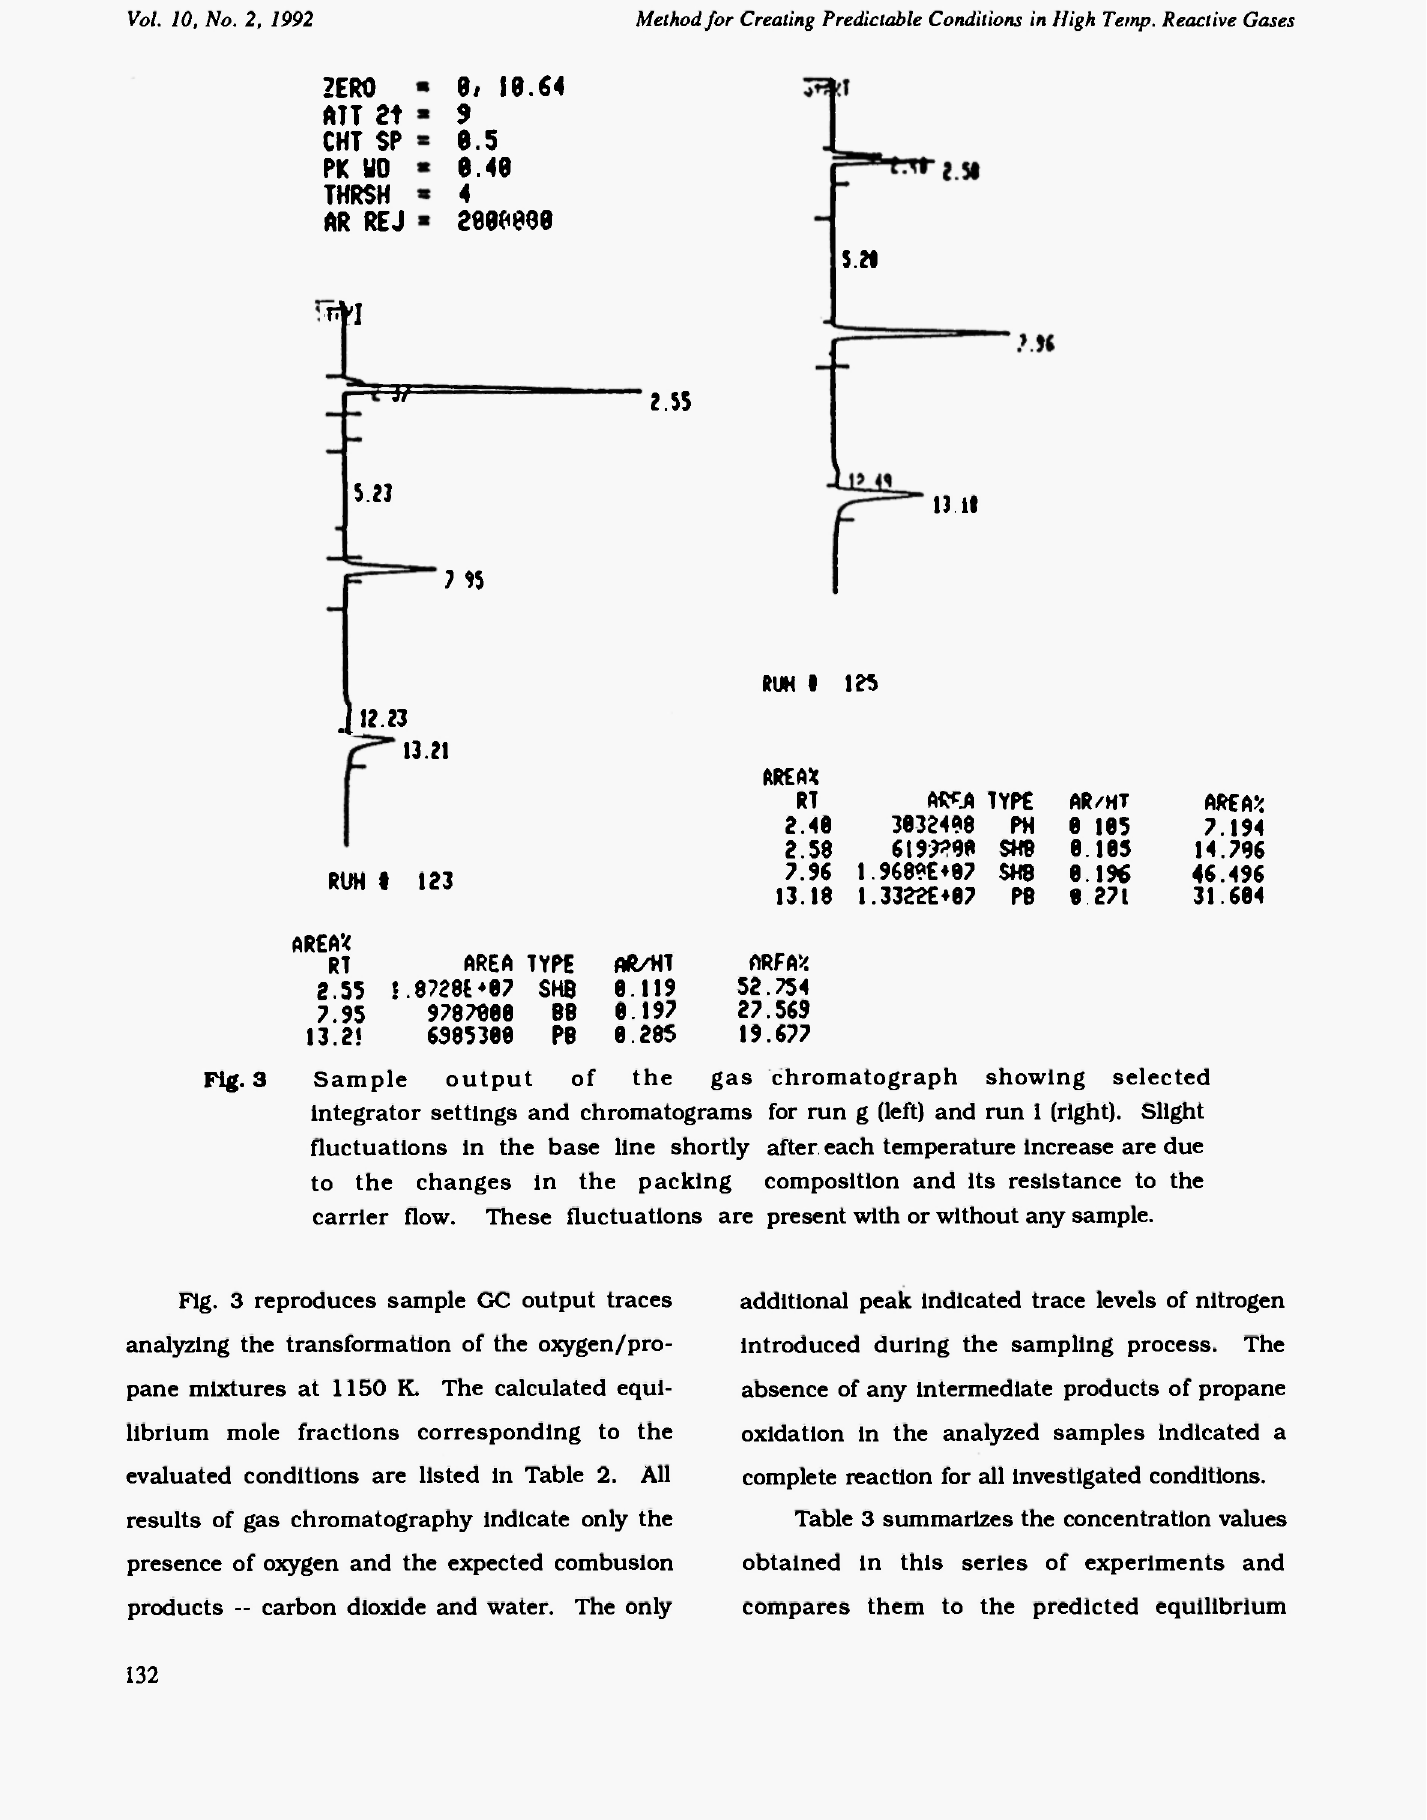
Fig. 3 Sample o u t p ut of the gas Chromatograph showing selected Integrator settings and chromatograms for run g (left) and run 1 (right). Slight fluctuations in the base line shortly after each temperature increase are due to the changes in the packing composition and its resistance to the carrier flow. These fluctuations are present with or without any sample.